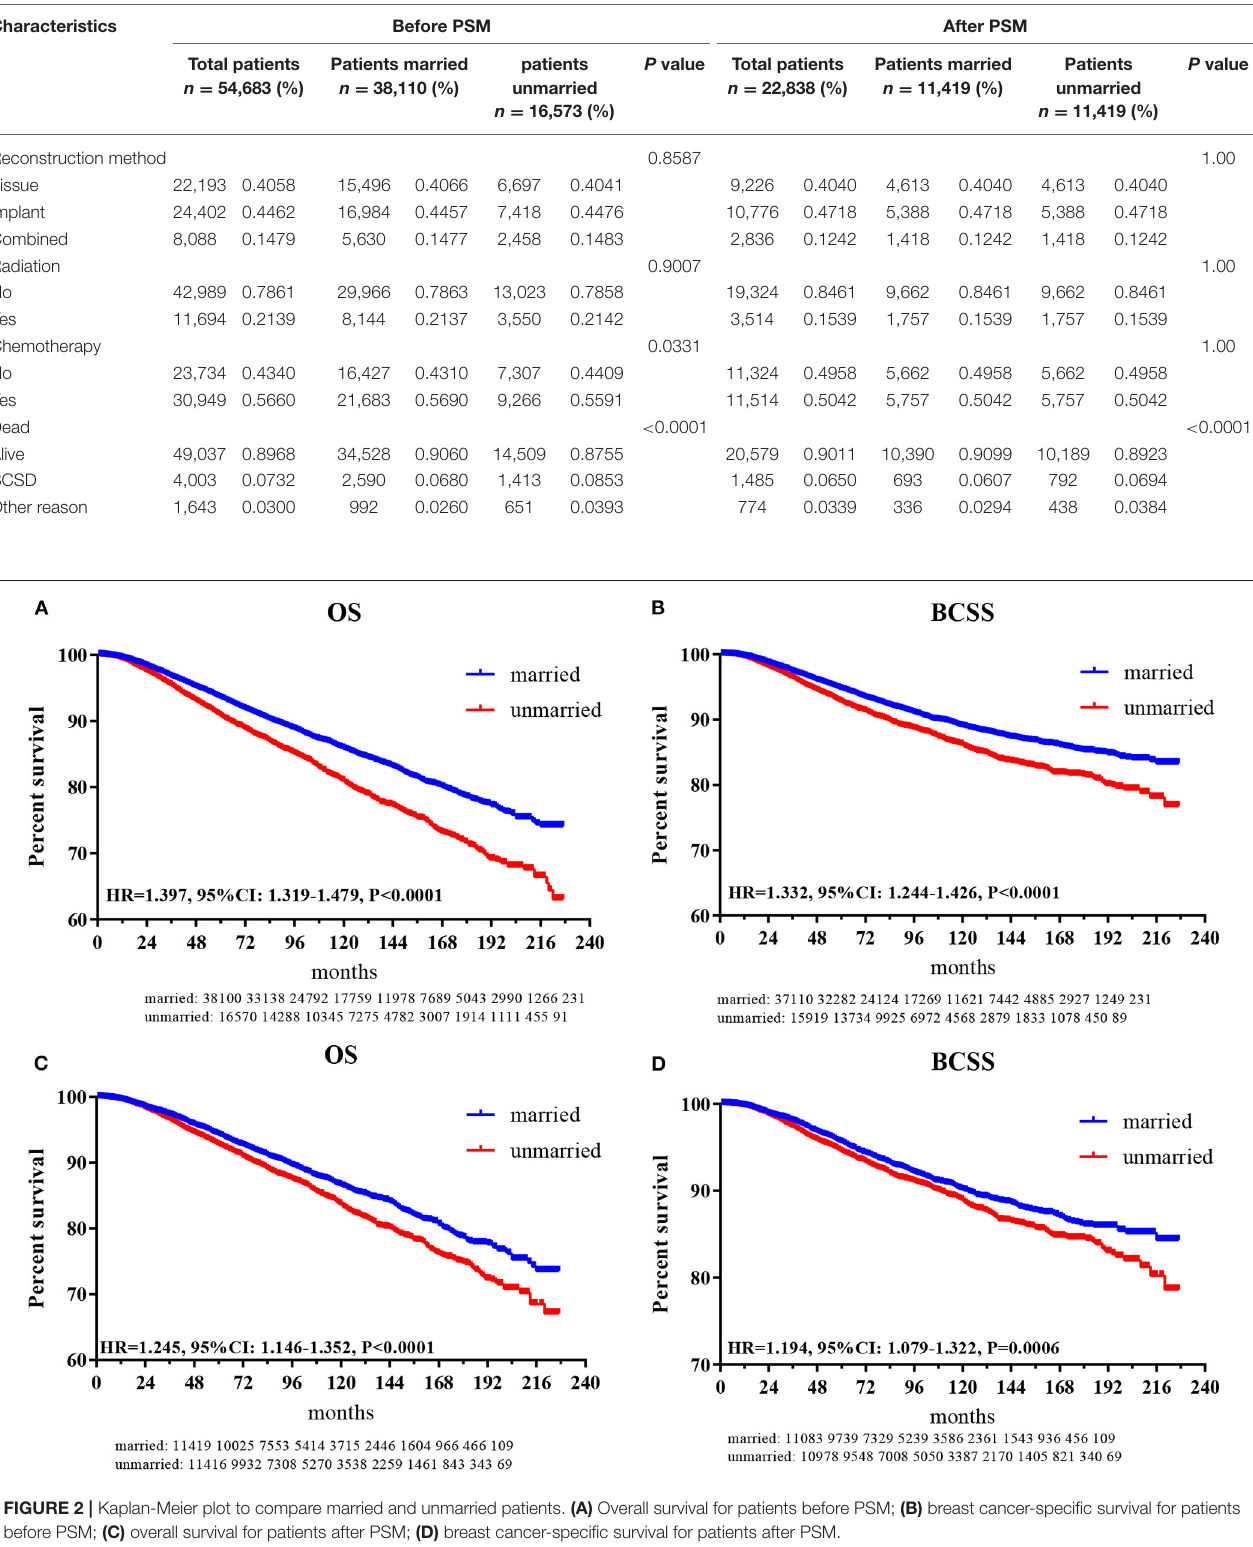
Frontiers in Surgery |